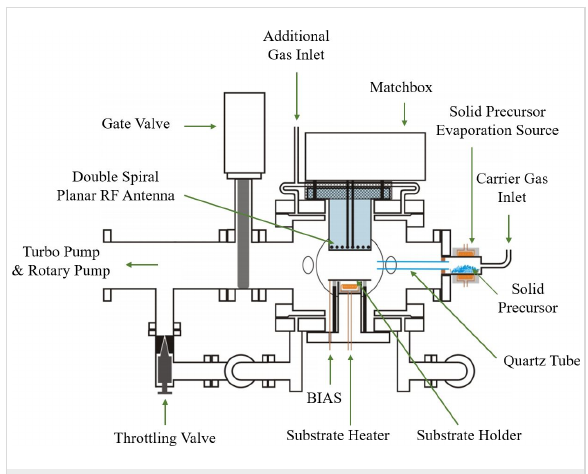
Figure 2: Schematic diagram of ICP-PECVD plasma source.